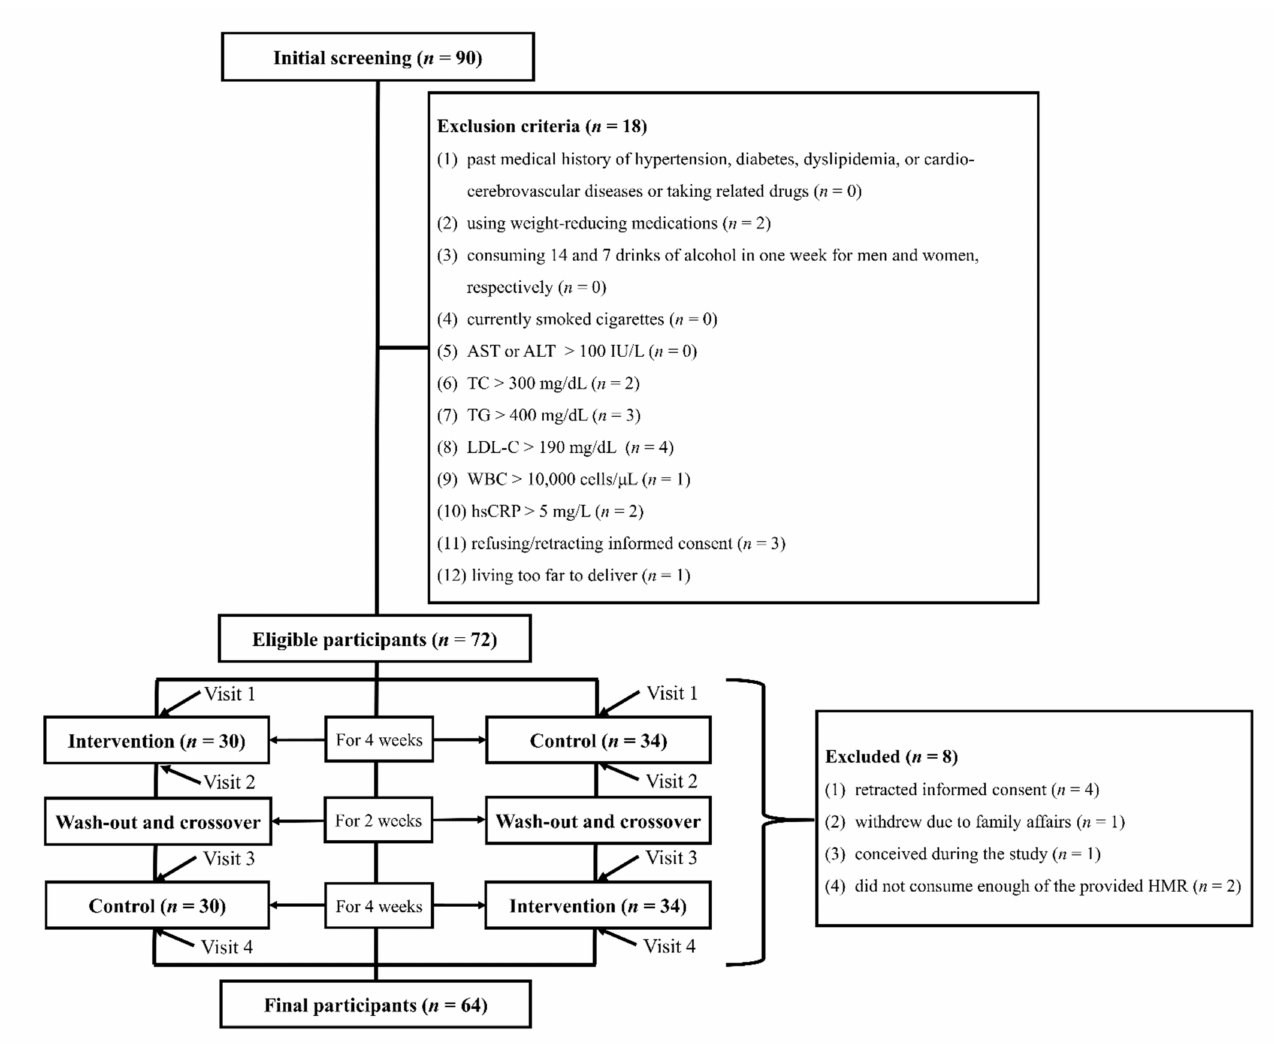
Figure 1. Flowchart of participant exclusion. Abbreviations: AST, aspartate aminotransferase; ALT, alanine aminotransferase; TC, total cholesterol; TG, triglycerides; LDL-C, low-density lipoprotein cholesterol; WBC, white blood cell count; hsCRP, high-sensitivity C-reactive